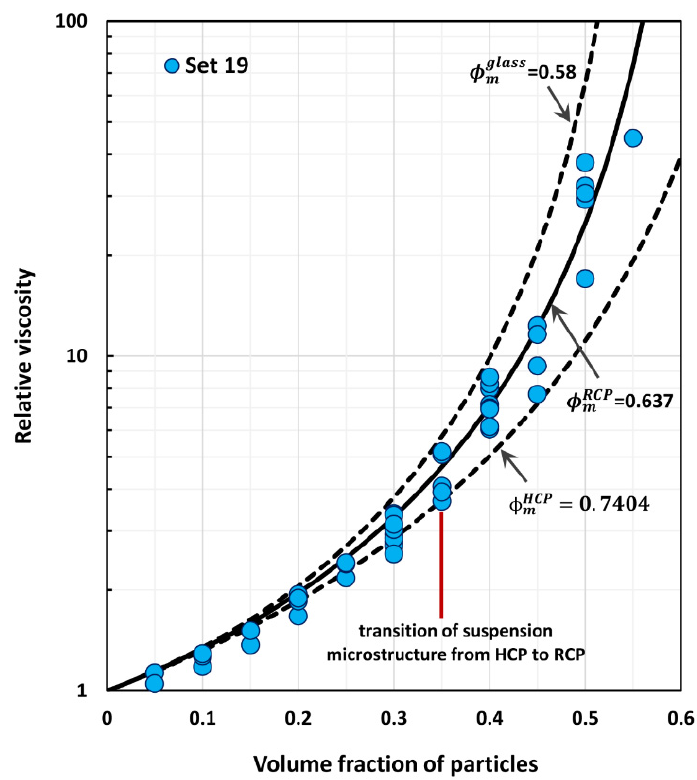
Figure 17. Transition in suspension microstructure from hexagonally close packed (HCP) clusters to randomly packed clusters (RCP) at a particle volume fraction of about 0.35.